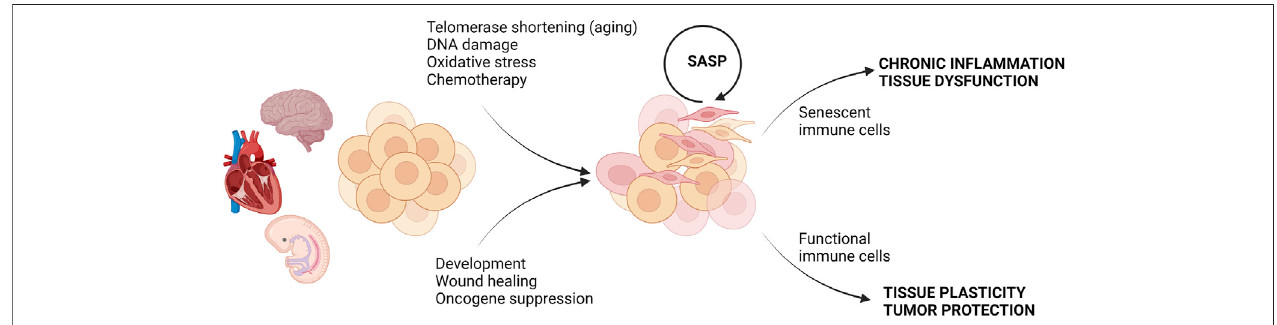
FIGURE 1 | Consequences of cell senescence in health and disease. Different types of stress or physiological conditions can trigger senescence. In embryonic development and tissue repair, senescence is bene fi cial and clearance of senescent cells by functional immune cells restores tissue function. In contrast, the accumulation of senescent cells under stress conditions can be further exacerbated by SASP, and failure of the removal of senescent cells by senescent immune cells can lead to chronic in fl ammation and tissue dysfunction. Created with BioRender.com.